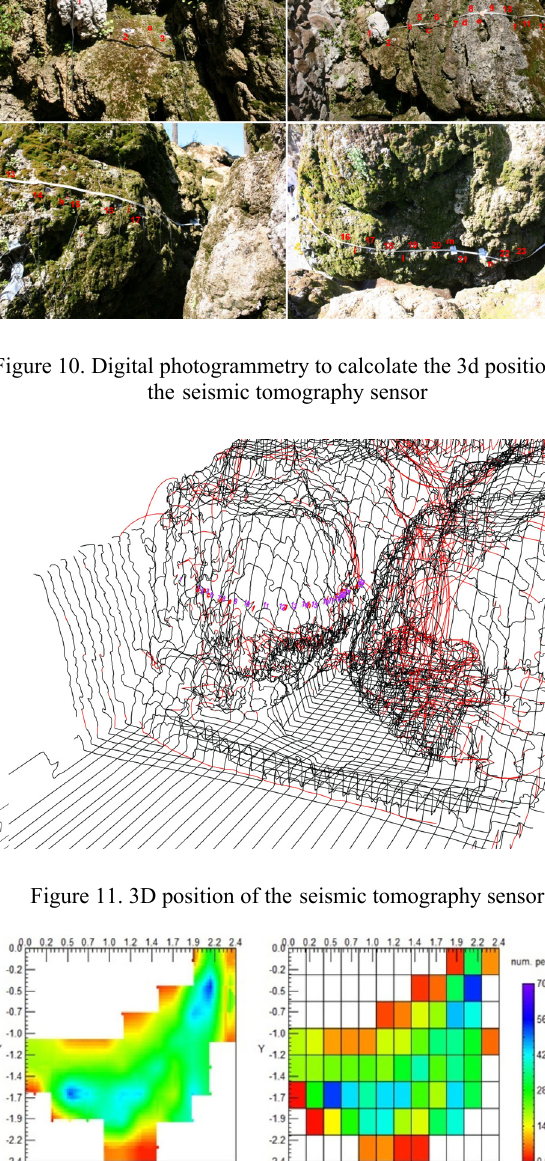
Figure 12. Distribution of the number of the raypaths that are directly linked to the quality of the material (High number it means better quality low number low